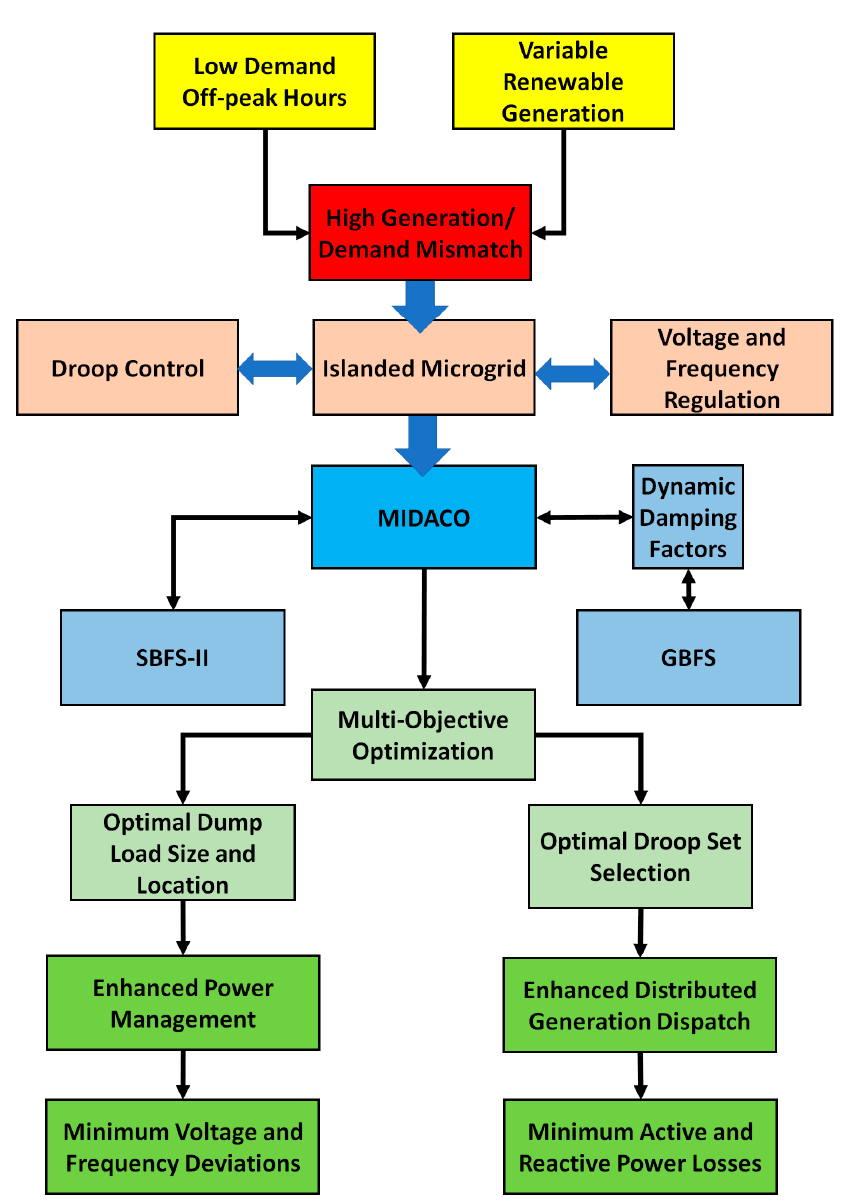
Figure 1. Generic flow chart for dump load allocation in